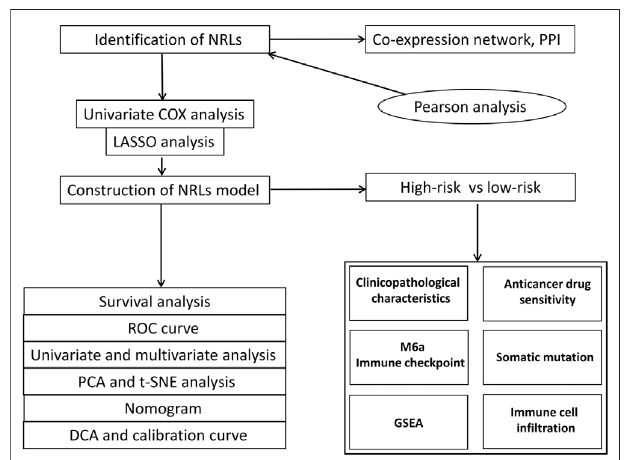
FIGURE 1 | Research fl ow